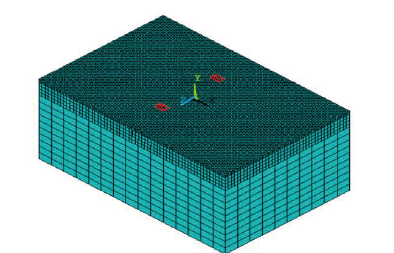
Figure 2. Model mesh Figure 3. Axle load and tires contact